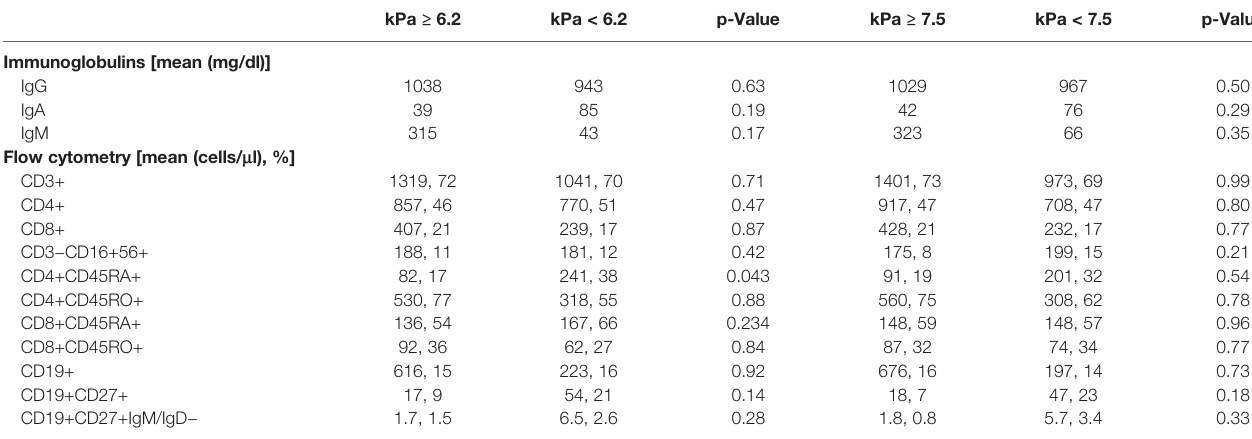
TABLE 2 | Relationship between peripheral blood immunophenotypes and liver stiffness cutoffs for NRH in CVID patients.